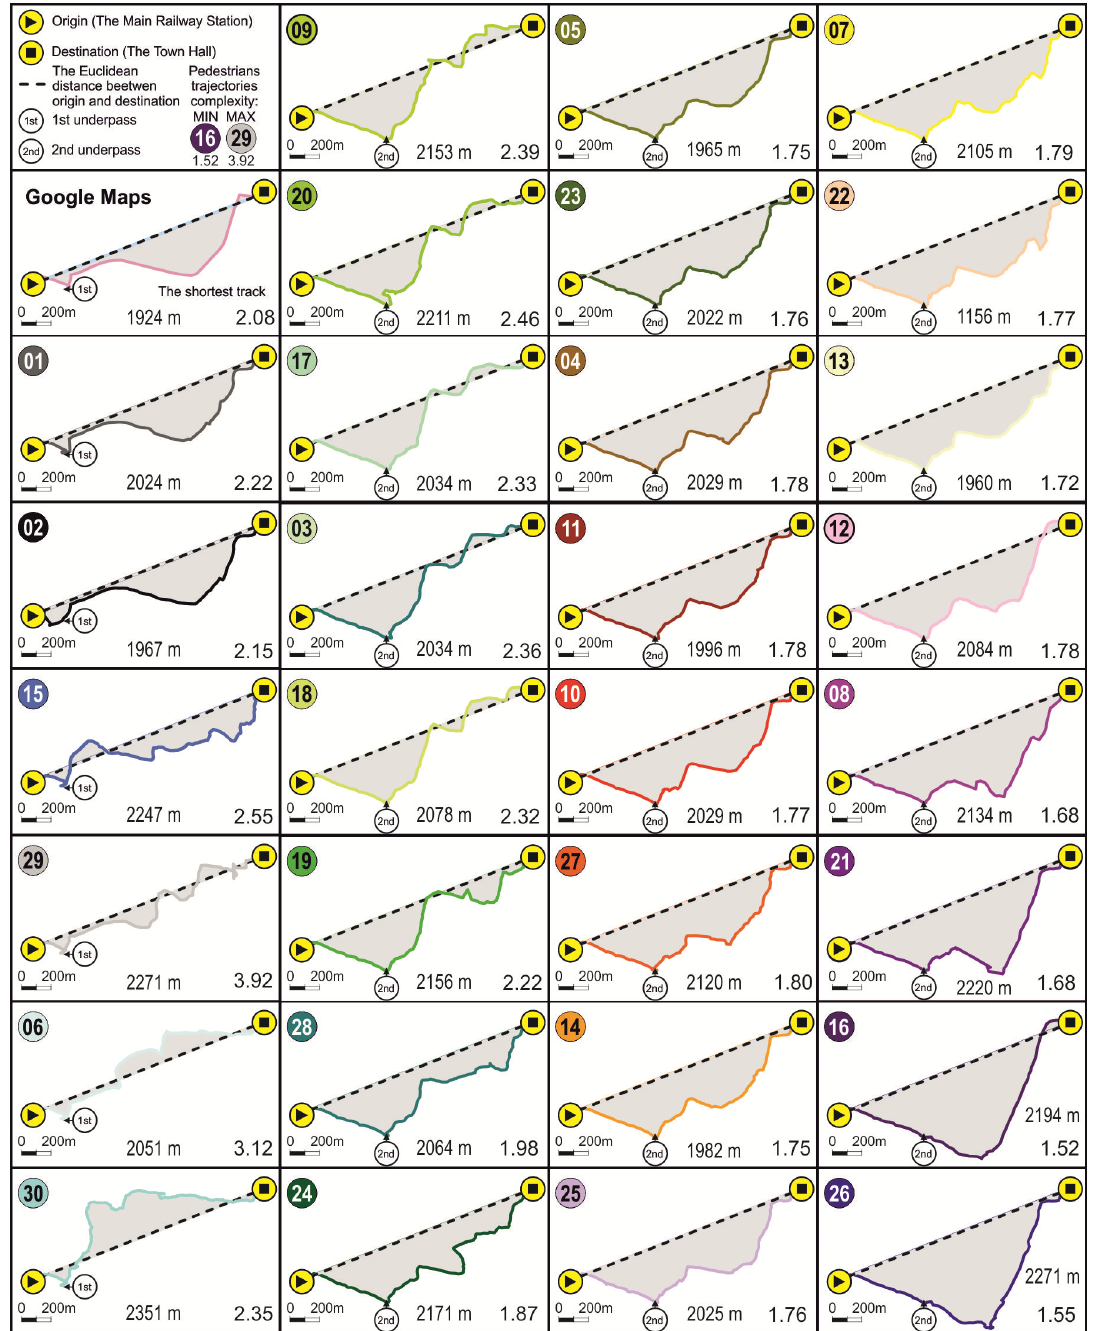
Figure 3. Miniatures of 30 routes of the research participants and the shortest route indicated by Google Maps along with the value of trajectory shape factor.